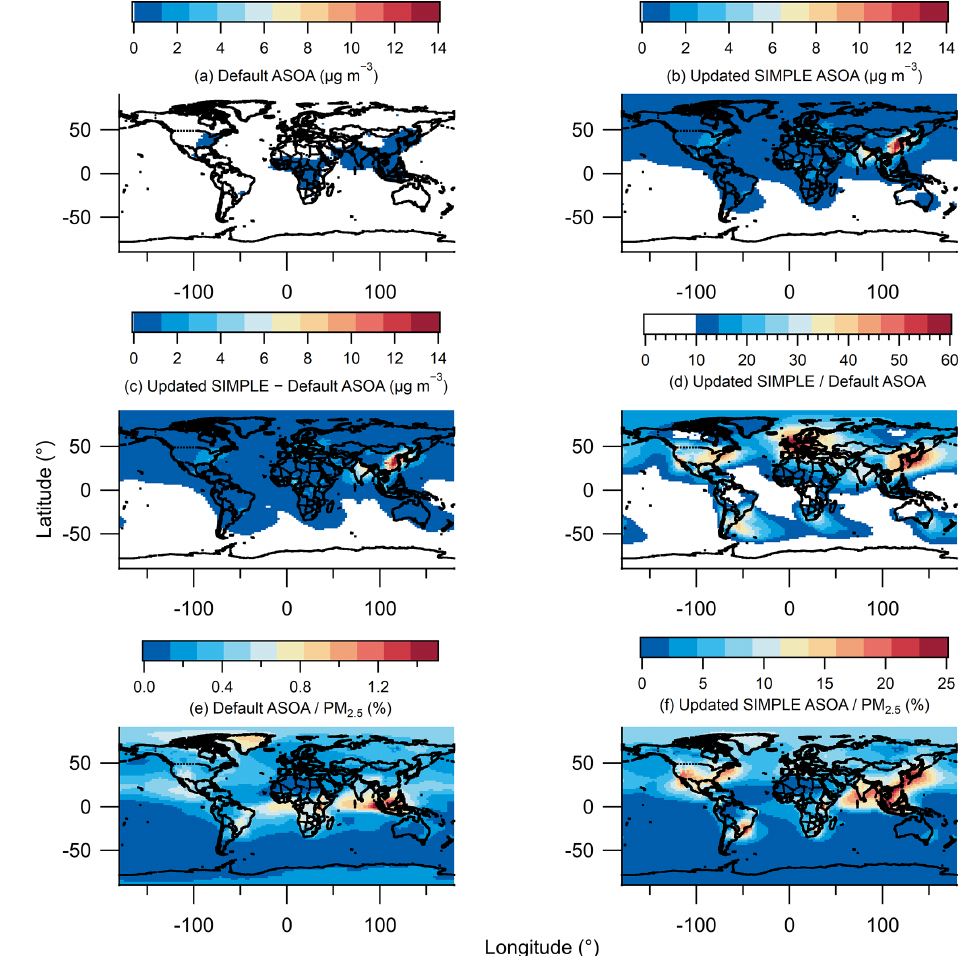
Figure 6. (a) Annual average modeled ASOA using the default VBS. (b) Annual average modeled ASOA using the updated SIMPLE model. (c) Difference between the annual average modeled updated SIMPLE and default VBS. Note that values less than 0.05µgm − 3 are white in panels (a) and (b) , and values less than 0.02µgm − 3 are white in panel (c) . (d) The ratio between the annual average modeled updated SIMPLE (b) and default VBS (a) . (e) The percent contribution of annual average modeled ASOA using default VBS to total modeled PM 2 . 5 . (f) The percent contribution of the annual average modeled ASOA using updated SIMPLE to total modeled PM 2 . 5